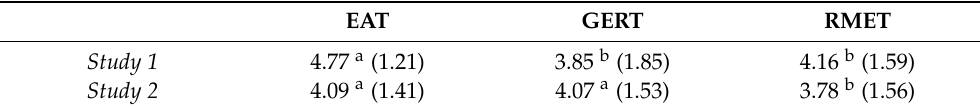
Figure 1. The relationship between accurate emotion recognition on the EAT and the GERT ( left ) and the RMET ( right ), in Study 1 (upper panel) and Study 2 (lower panel). Note. Grey denotes 95% confidence intervals. Table 3. Mean (and SD) values of enjoyment participants reported for the completion of the EAT vs. the RMET vs. GERT tasks, in Study 1 (USA) and Study 2